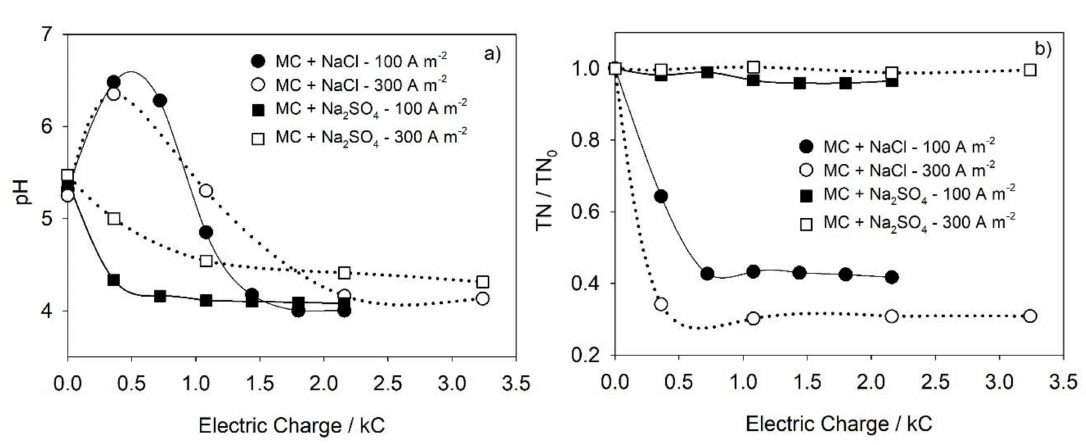
Figure 2. Variation with applied charge of the ( a ) pH and ( b ) normalized total nitrogen (TN) for the EO experiments performed at 100 and 300 A m − 2 using Na 2 SO 4 or NaCl as the supporting